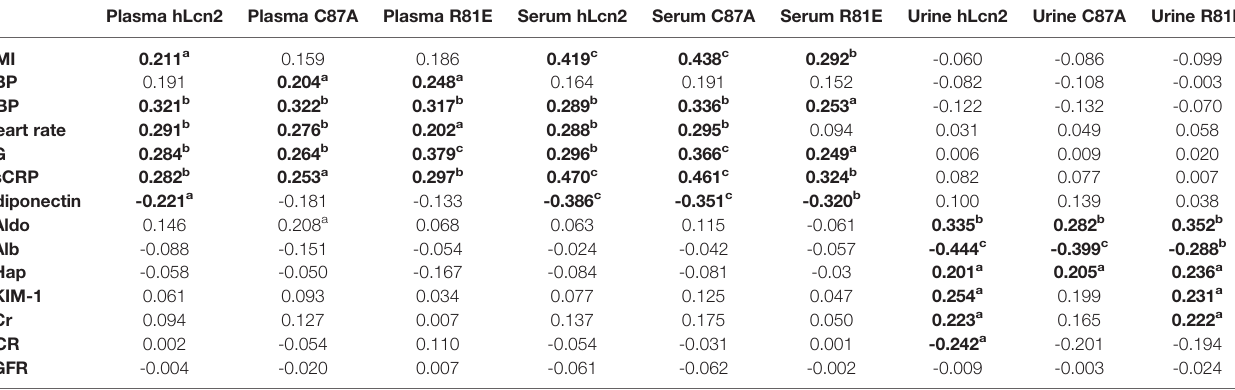
TABLE 4 | Correlations between LCN2 variants and study variables.